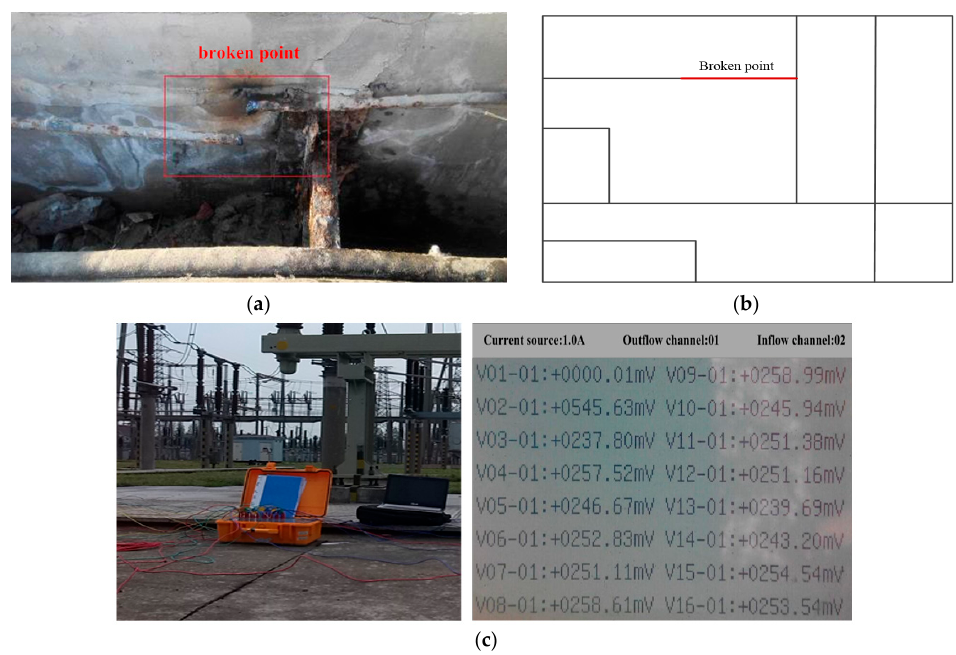
Figure 16. The field experiment. ( a ) The scene photo; ( b ) The model diagram; ( c ) The process of diagnosis.